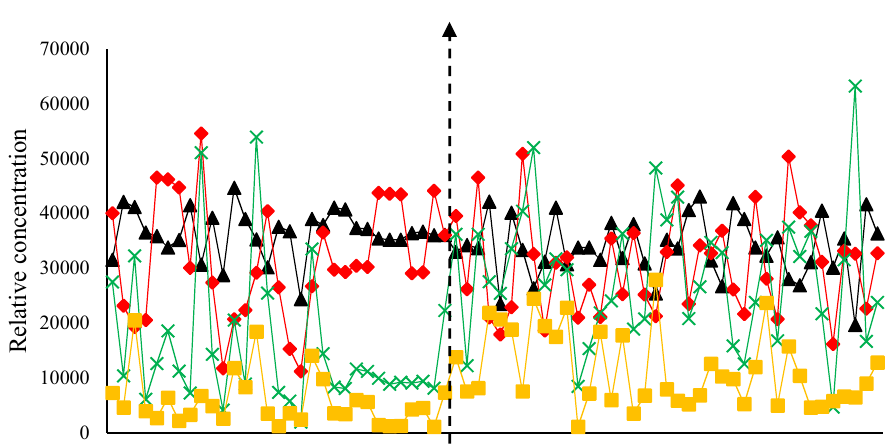
Figure 3. Mode 1 loadings (relative concentrations y-axis) from non-negative constrained four-component PARAFAC model, and how they vary for the different samples (x-axis). Samples of Maltese origin are denoted by the letter M, whilst foreign samples are denoted by the letter F. Black ( ▲ ) line indicates the relative concentration of chlorophyll pigments; green line (x) represents the tocopherol content; yellow line ( ■ ) represents the phenolic content; red line ( ♦ ) represents the oxidation products.